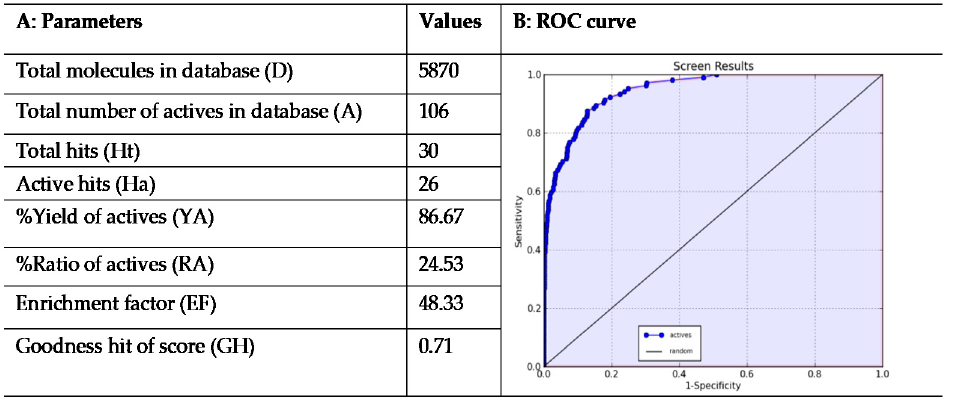
Figure 7. ( A ) EF and GH scores obtained by the application of 3D-QSAR model in a database screening; and ( B ) receiver-operating characteristic (ROC) curve generated from database screening.